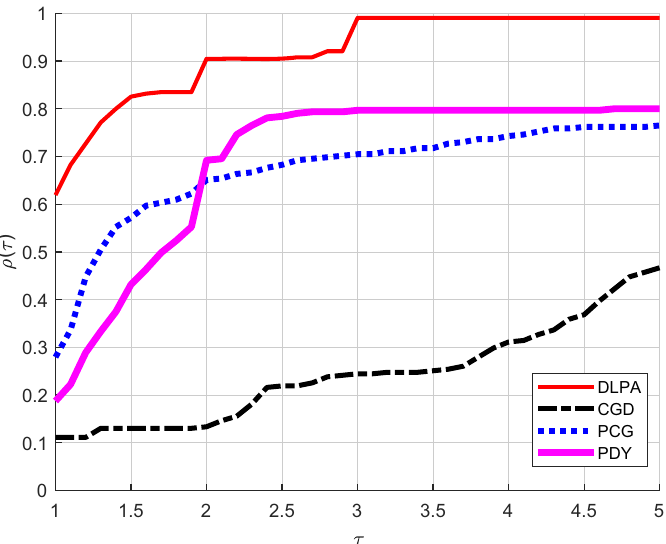
Figure 1: Performance pro fi le of DLPA, CGD, PCG, and PDY methods in terms of number of